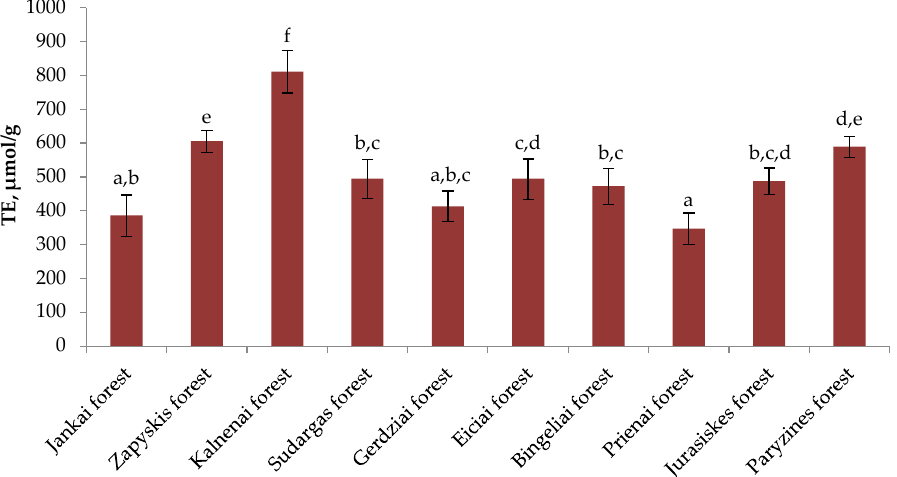
Figure 3. Variation of reducing activity (TE, µ mol/g) in different Lithuanian wild habitats; different letters indicate statistically significant differences between heather samples ( p < 0.05).